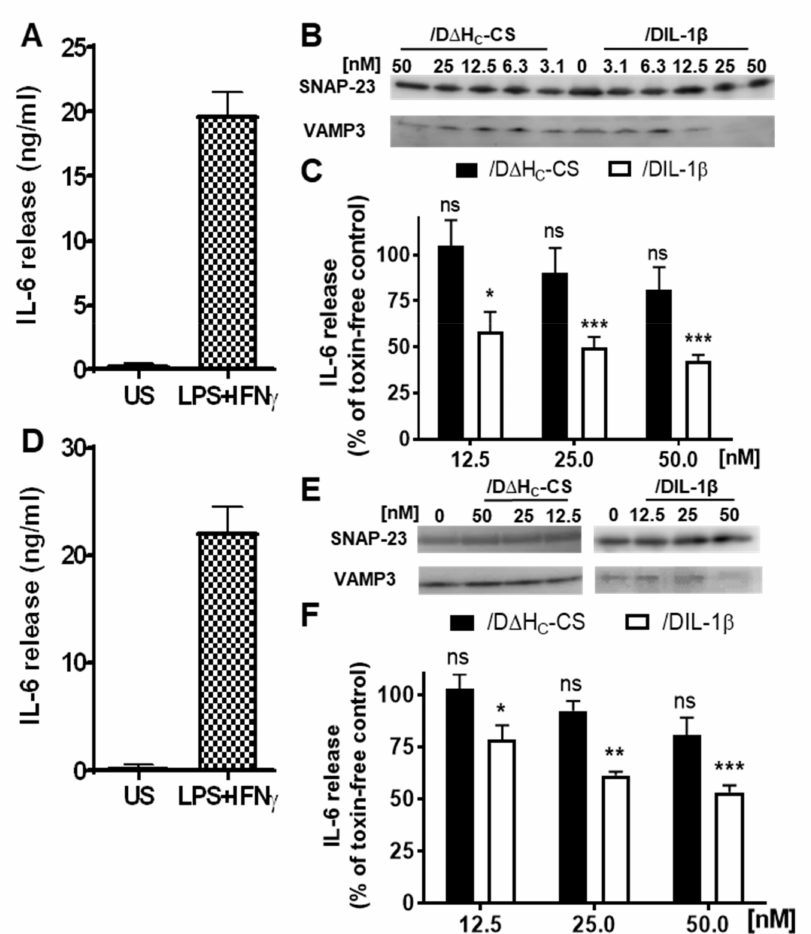
Figure 4. / DIL-1 β entered the cultured macrophages, cleaved VAMP3 and inhibited evoked IL-6 release, unlike the untargeted control. ( A ) Treatment of RAW 264.7 cells with LPS and IFN γ for 42 h induced substantial IL-6 release in comparison to unstimulated (US) cells. ( B ) Cleavage of VAMP 3 in RAW 264.7 cells by treated proteins was probed by Western blotting using an antibody against VAMP1 / 2 / 3 forms. Note that RAW cells predominately express the VAMP3 isoform (Figure S1). It is worth noting that the antibody used only recognises the intact but not the BoNT / D-protease-cleaved form. SNAP-23 was probed as an internal loading control. ( C ) / DIL-1 β and / D ∆ H C -CS inhibited LPS and IFN γ evoked IL-6 release from the cultured RAW 264.7 cells to di ff erent extents. ( D – F ) Experiments were repeated as for ( A – C ), except primary mouse macrophage cells were used. Data plotted are mean ± S.E.M. ( n = 3). Significance between / DIL-1 β or / D ∆ H C -CS treated cells and toxin non-treated control cells is indicated as follows: non-significant (ns), p > 0.05; * p < 0.05; ** p < 0.01 and *** p <